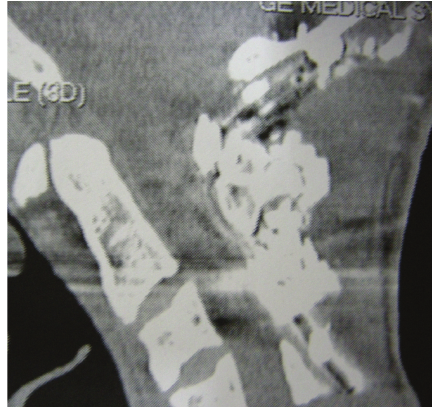
Figure 4: Computed tomography scan showing an occipito- cervical stable fusion at the 3-year followup.